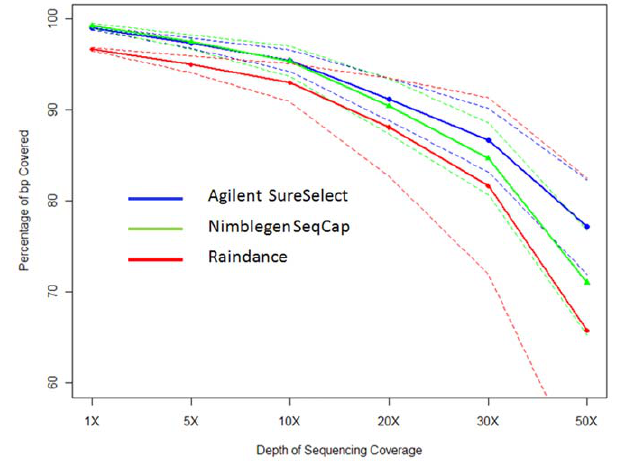
Figure 1. Depth of sequencing coverage of matched sample set (N=6 unique samples). Percent of on-target bases (y-axis) covered at a given sequence depth (x-axis). On target percentage calculated as the fraction of nucleotide bases falling on targeted regions divided by the total number of nucleotides mapping anywhere in the genome. Thick lines represent average coverage for each platform (Agilent Sure- lect=blue circles; Nimblegen SeqCap=green triangles; Raindance parallel PCR=red diamonds). Dashed lines represent two standard deviations above and below the average for each platform.